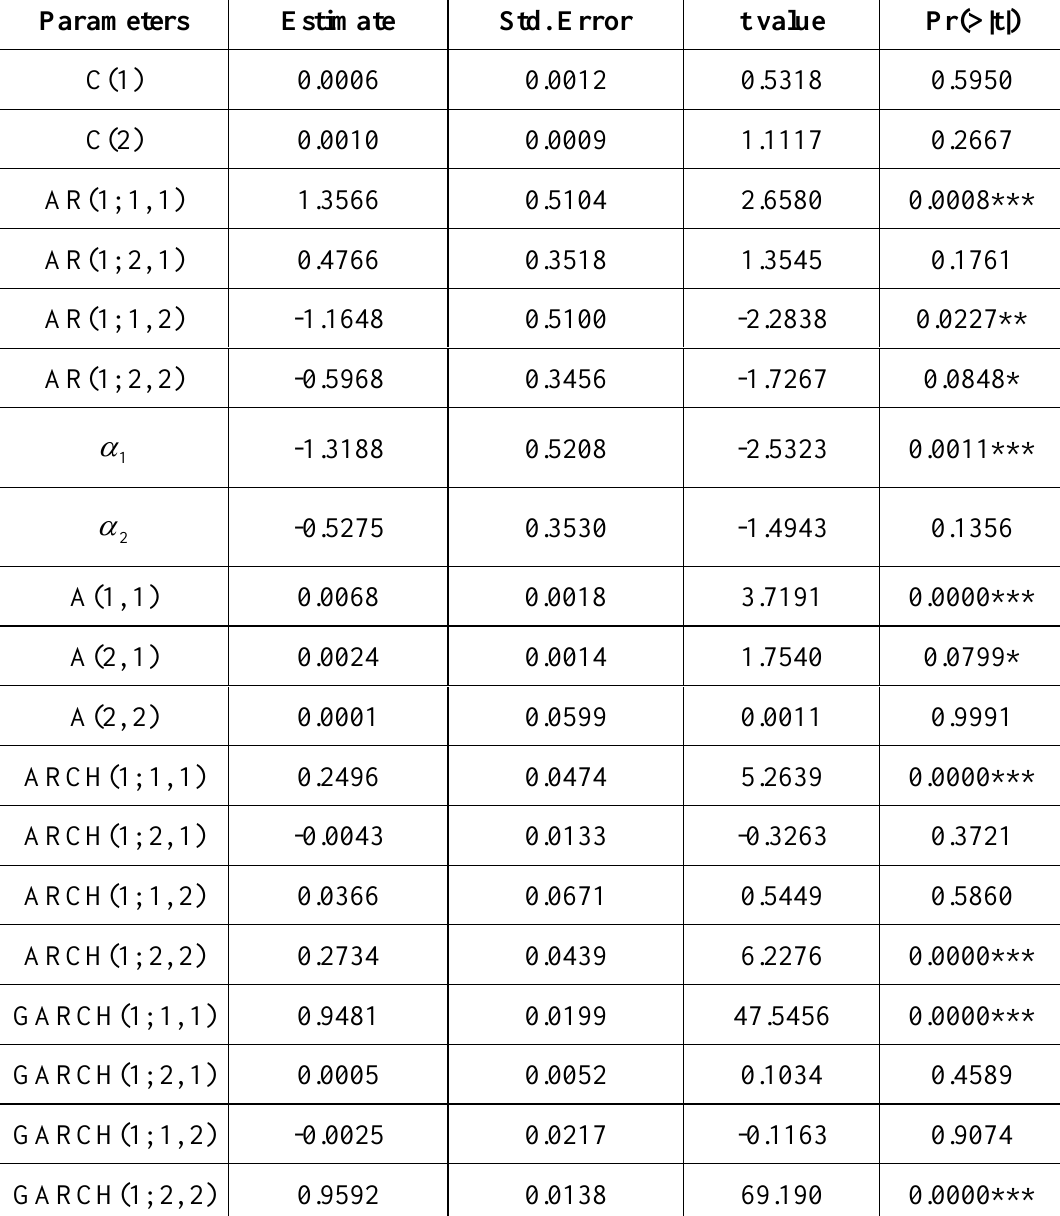
Table 6: Estimated coefficients for FIVECM-BEKK(1,1) fitted on ),( ′∆∆